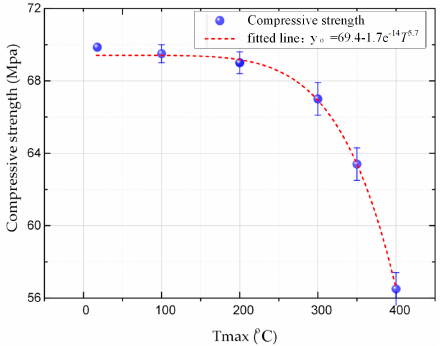
Figure 4. The variation of compressive strength with thermal shock temperature after a single thermal shock.